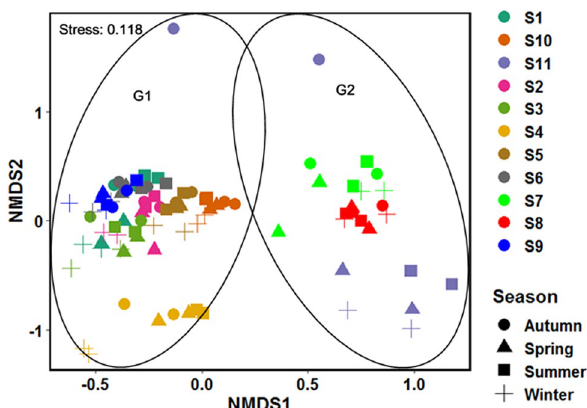
Figure 2. NMDS ordinates of periphytic algal abundance data at eleven sampling stations across the